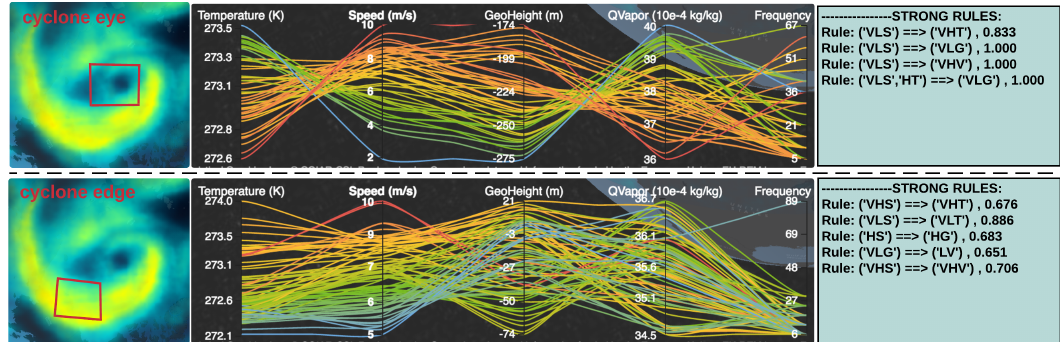
Figure 7. Comparison of data distribution pattern in the PCP view and generated rules between cyclone eye and cyclone edge. The data distribution patterns in the PCP view are different, leading to the discovery of different strong association